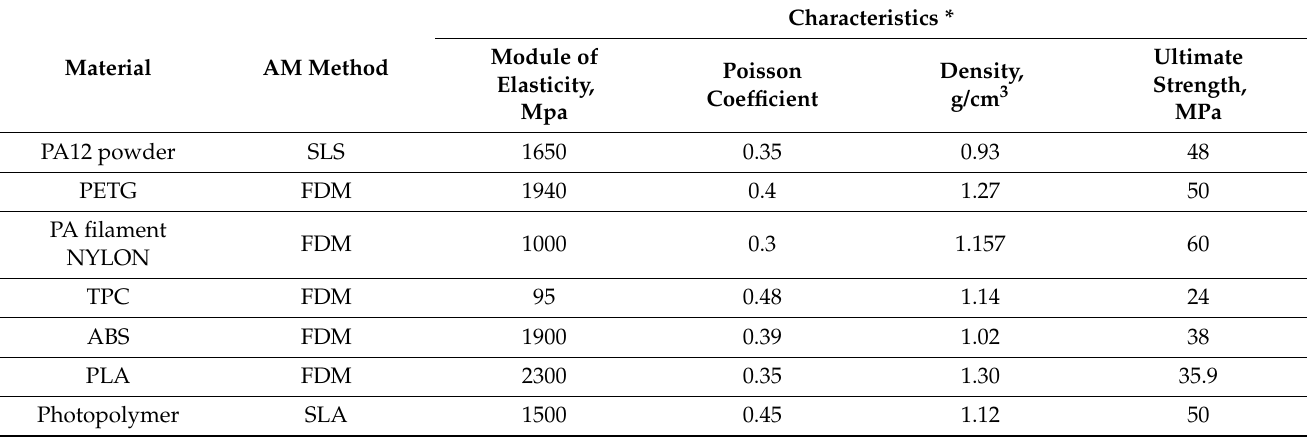
Table 1. Characteristics of applied materials and used additive manufacturing methods.